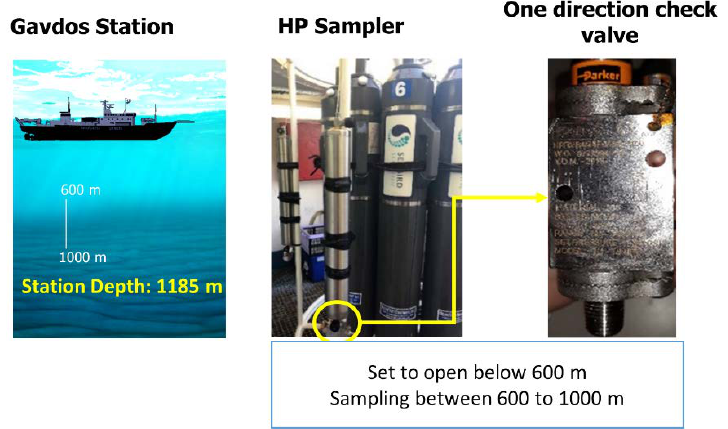
Figure 2. Schematic of the high-pressure deep-sea sampling. HP-sampler in the middle as attached to the CTD rosette on board. Close up of the one direction check valve on the right.